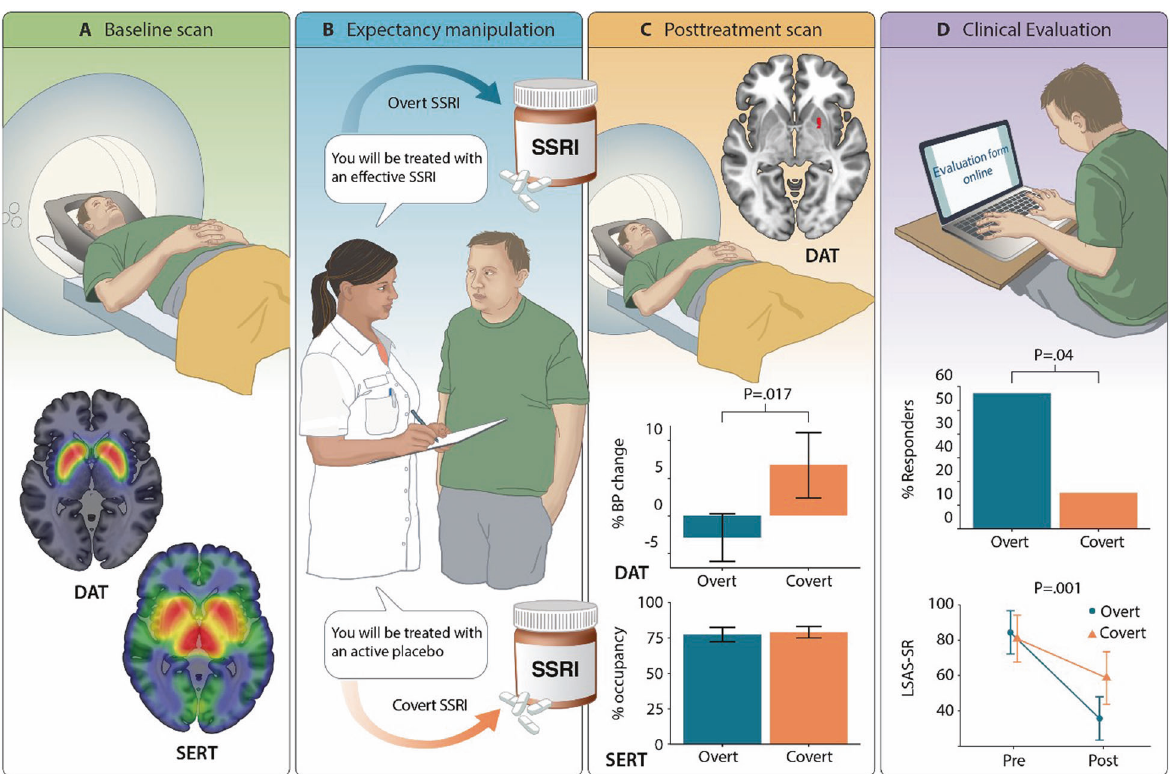
Fig. 1 Study design and main results. A Shows the whole-sample distribution of serotonin (SERT) and dopamine (DAT) transporters, expressed as non-displacable binding potentials (BP ND ) at the baseline PET assessment. B Illustrates the experimental manipulation; high or low response expectancies were induced by different verbal instructions. All patients were then treated under randomized conditions with escitalopram 20 mg for 9 weeks, correctly described as an effective SSRI for the overt group and incorrectly described as an active placebo in the covert group. C Shows the treatment effects on PET measures. Overt as compared to covert SSRI treatment resulted in lowered DAT availability, the signi fi cant cluster in the right putamen/pallidum is shown together with percent BP ND change from pre- to posttreatment. In contrast, the average escitalopram SERT occupancy levels were similar in both groups after treatment. D Shows the results of the clinical evaluation. Overt as compared to covert treatment resulted in a signi fi cantly higher percentage responders and lowered (pre-post) social anxiety as assessed with the Liebowitz Social Anxiety Scale, self-report (LSAS-SR) administered online. Error bars re fl ect 95% con fi dence